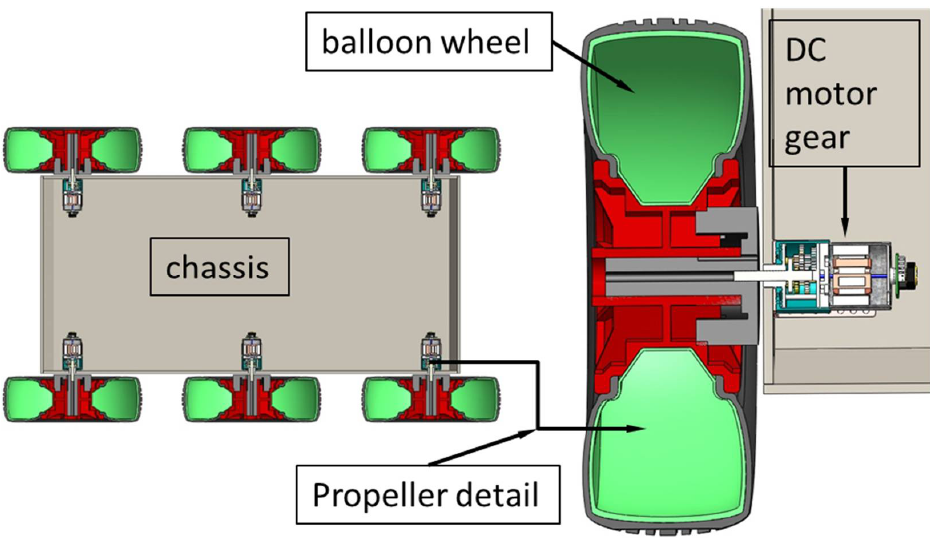
Figure 4. Schematic representation of the propulsion system of the 6 × 6 robot for emergency situations consists of six motors with a gearbox, six wheels with rubber tires, and a nodular balloon inflated with air for more efficient damping of the unevenness of the route during movement of the robot.